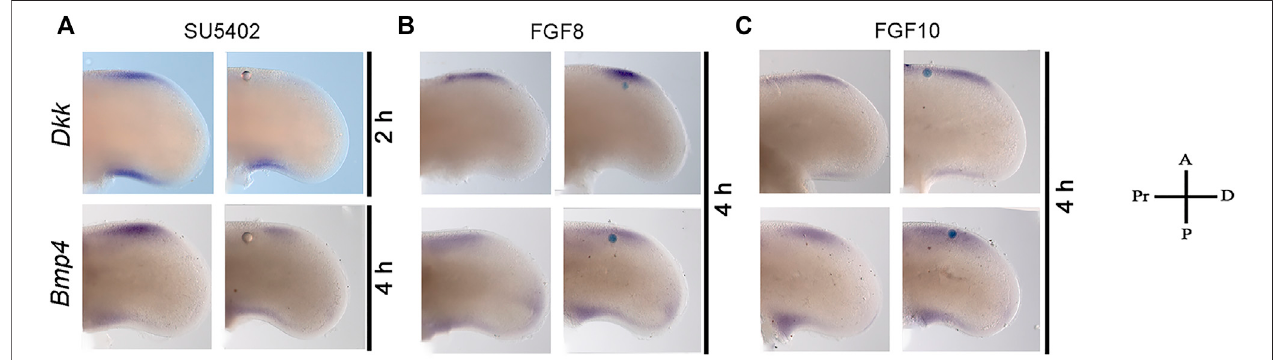
FIGURE 4 | Inhibition of Dkk and Bmp4 gene expression by treatment with an inhibitor on FGF signaling. Gene expression pattern of Bmp4 and Dkk in the anterior margin of the limb at developing stage 24HH. (A) Dkk expression inhibition was observed after 2 h of treatment with SU5402, while Bmp4 was inhibited after 4 h. The gene expression pattern of Dkk and Bmp4 was not modi fi ed at least 4 h after (B) FGF8- and (C) FGF10-treatment.